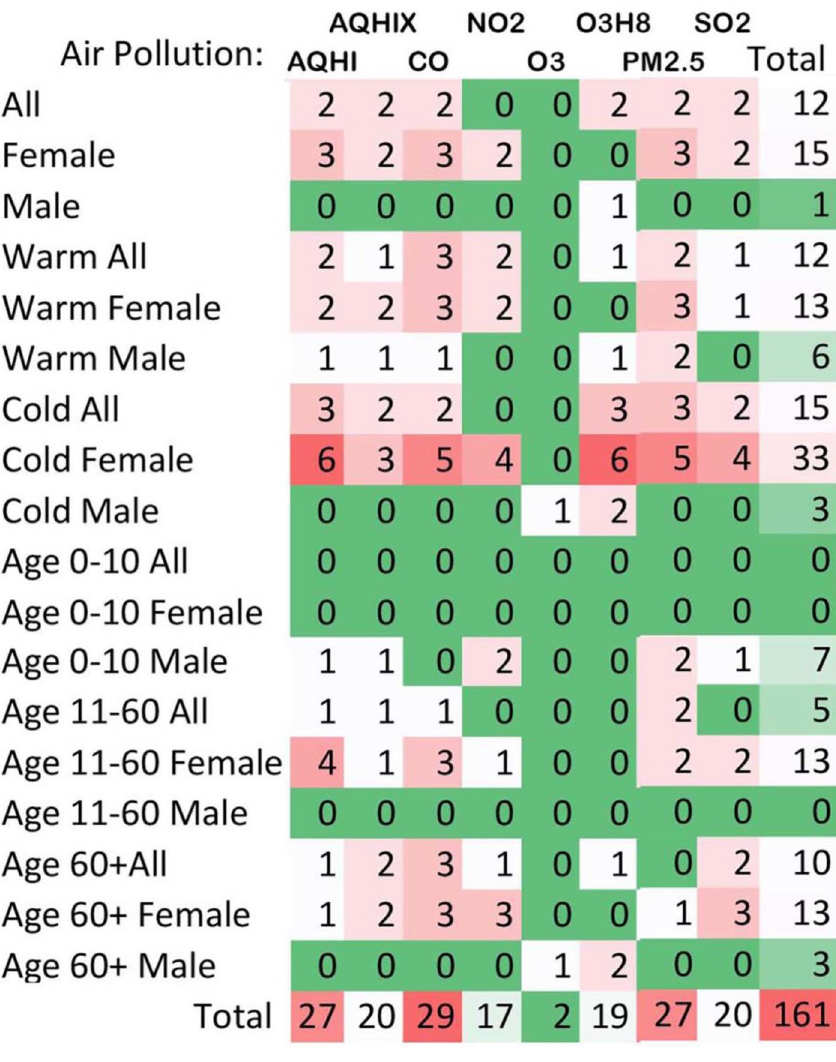
Fig 1. Total frequencies of all associations: 18 strata (rows), five air pollutants and two air quality health indices (columns) between ambient air pollutants levels and the number of ED visits for episodic and paroxysmal disorders (G40-G47) in Toronto, Canada from April 1, 2004 to December 31, 2015. For visual representation: 0 (green) colour represents others than positive statistically significant